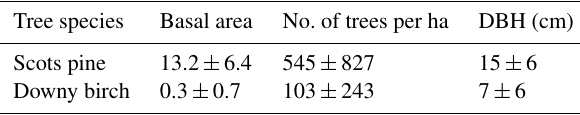
Table A2. Pine forest basal area, stand density, and diameter at breast height (DBH; mean ± standard deviation) derived from field measure- ments.